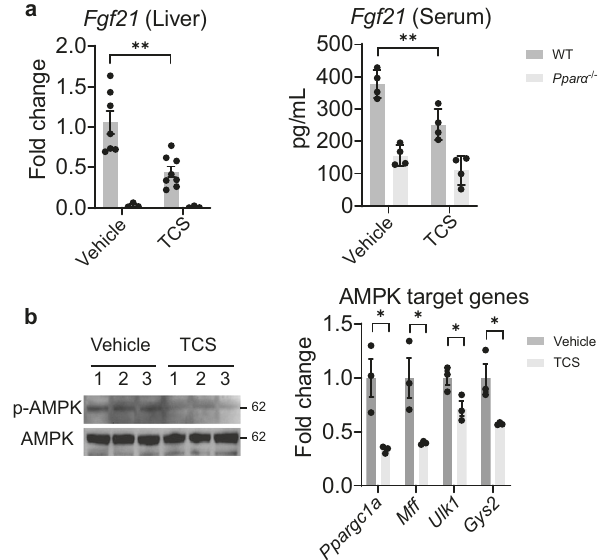
Fig.4|TCSblocks Fgf21 expressionandAMPKsignaling. WTmicebreastfedwith TCS or vehicle for 21 days. a Hepatic expression of Fgf21 was measured by Q-RT- PCR,vehicleWT, n =7;vehicle Ppar α − / − , n =3;TCSWT, n =8;TCS Ppar α − / − , n =3.and FGF21serumlevelswereevaluatedbyELISAin21-dayoldmice, n =4pergroup. b IB analysis of total and phosphorylated AMPK and expression of AMPK target genes fromTCSandWTmiceinliverof21-dayoldneonatalmice( n =3pergroup).( a )and ( b ) show mean ± S.E., determined by two-tailed Student ’ s test; * P <0.05, ** P <0.01. AM P K target genes used are signi fi cant and p adjusted value below the cut-off level of